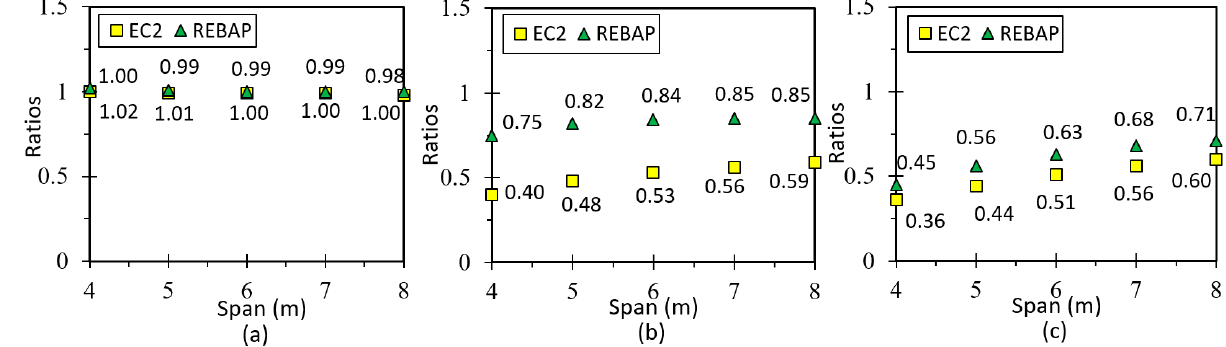
Figure 22. Ratios values for ( a ) LM, ( b ) 1NLM and ( c ) 2NLM, for fixed-ended slab.